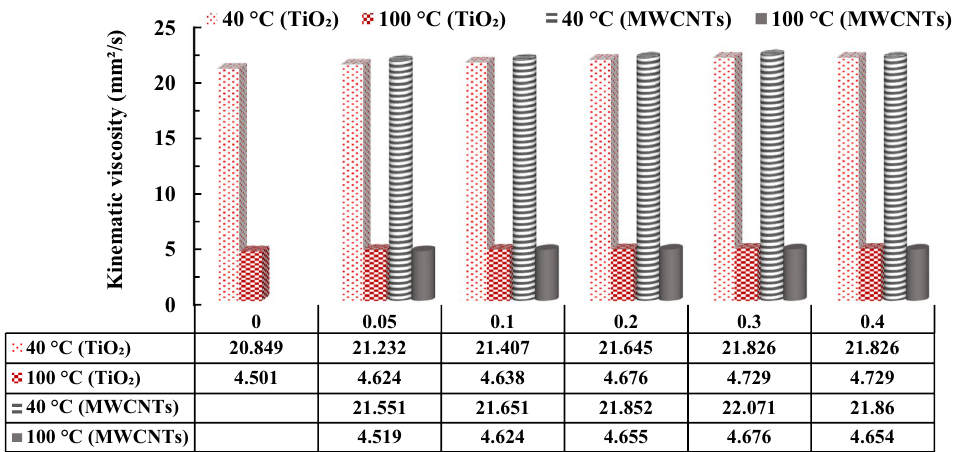
Figure 11. Comparison of the kinematic viscosity of TiO 2 /turbine meter oil and MWCNTs/turbine meter oil nanofluids in different mass fraction at 40 °C and 100